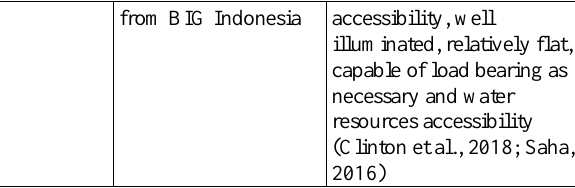
Table 3. Profile and characteristics of urban farming form Note: Ground □ and Rooftop ○ ; Meso # and Micro * ; Private ♦ and Community ▲